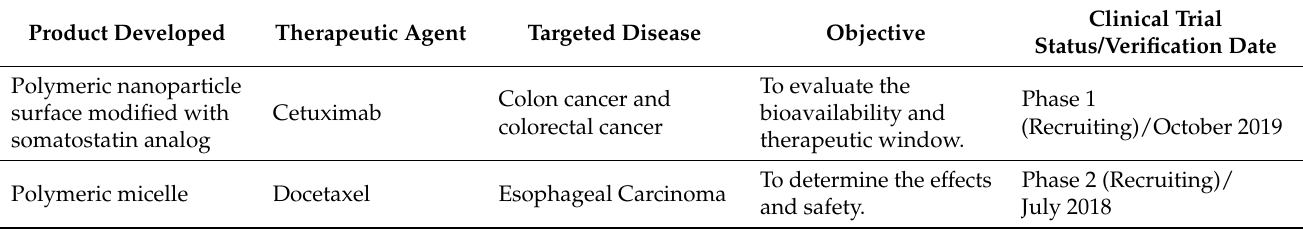
Table 7. A cross-section of reports on polymeric nanocarriers under clinical